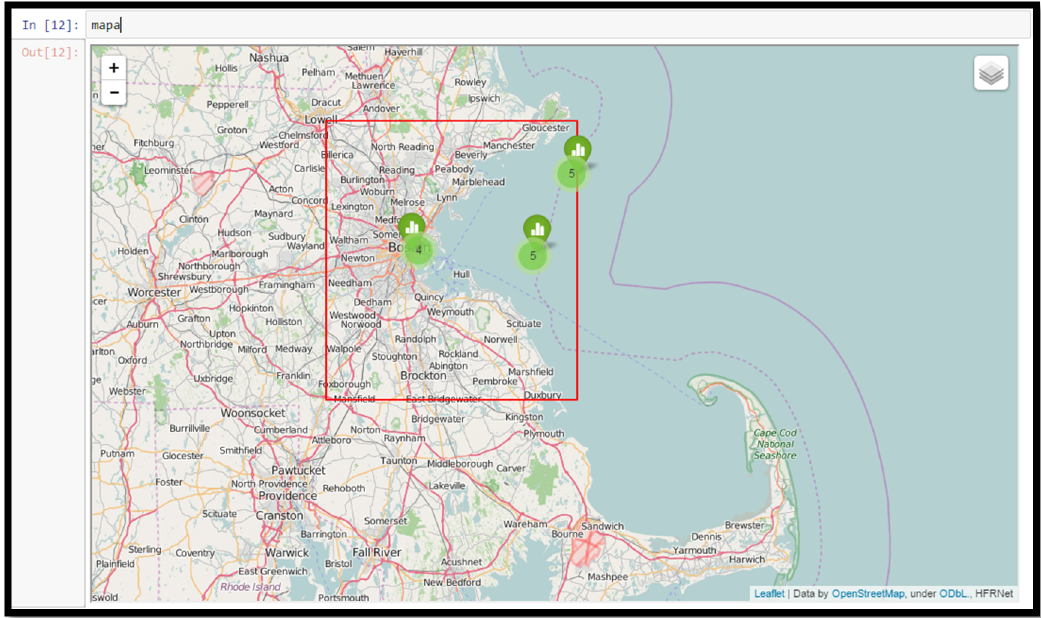
Figure 7. Screenshot from a section of the Map Display notebook, showing the region searched, the observational station locations, and the number of model datasets found at each station location. Clicking on the plot icon at each station location displays an interactive time series plot of the type shown in Figures 8 and 9.